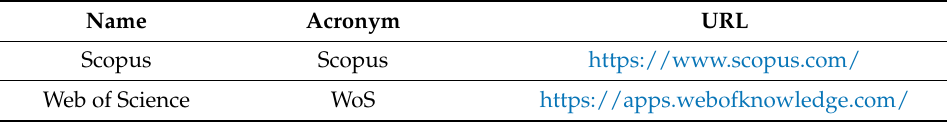
Table 1. Databases used in the search (accessed on 26 February